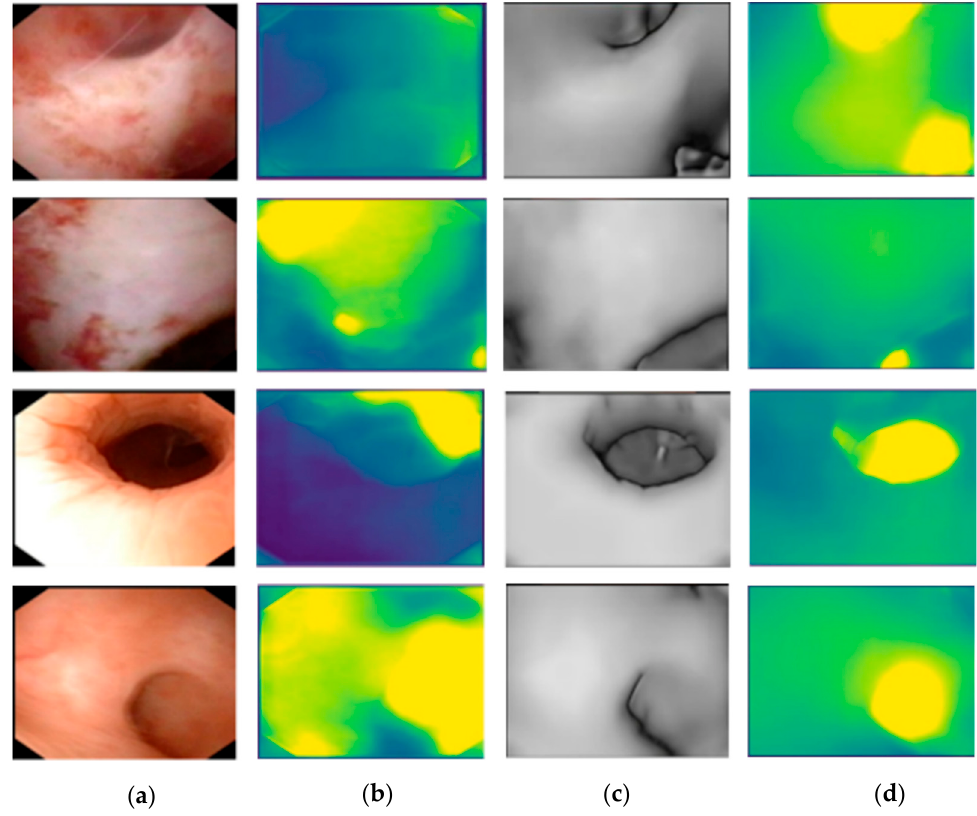
Figure 9. Examples of depth prediction of ureteroscopic video images by style transfer. ( a ) shows ureteroscopic images, ( b ) shows the results of direct depth prediction, ( c ) shows style transfer, and ( d ) shows depth prediction after style